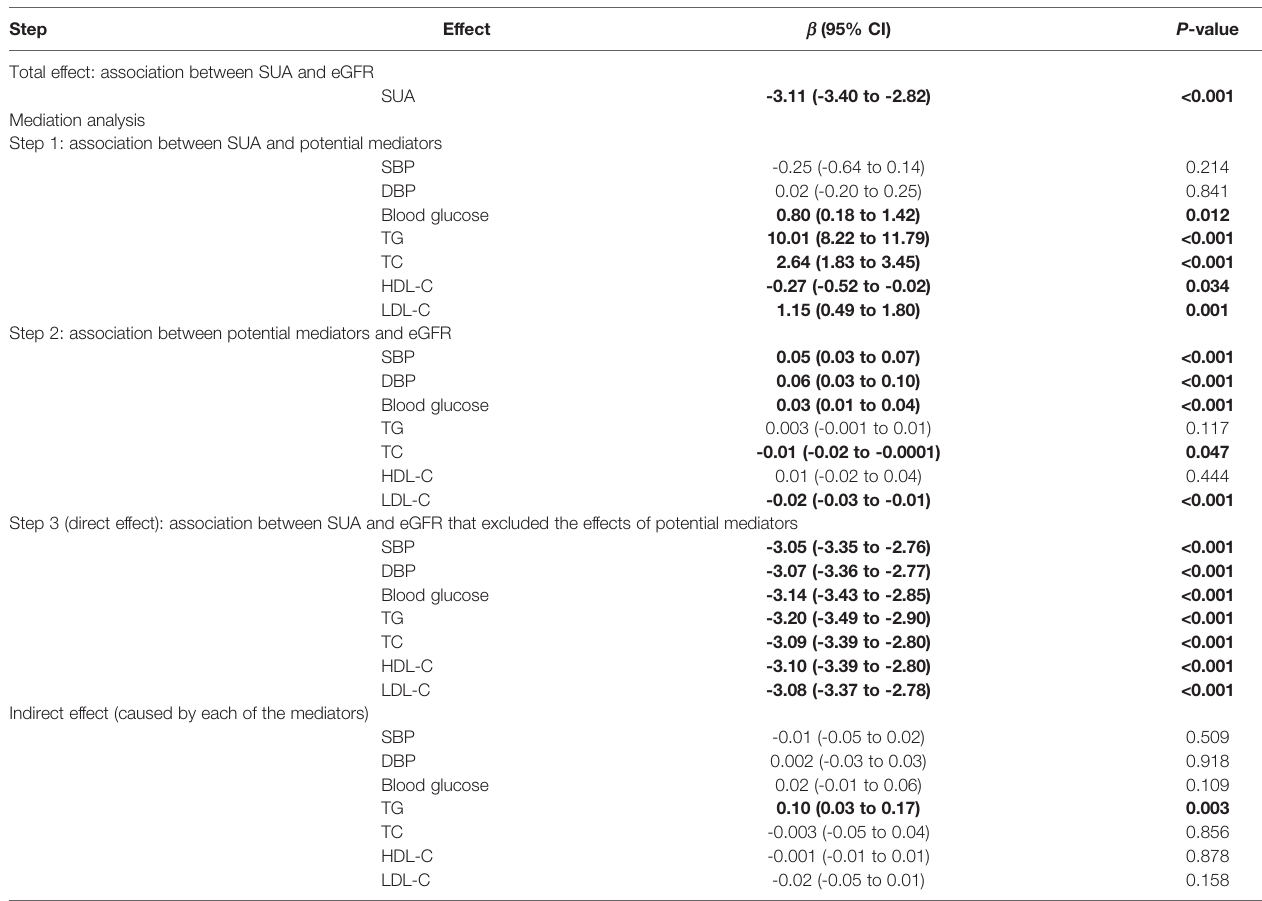
TABLE 2 | The mediating effects of cardiometabolic factors on the association between SUA and